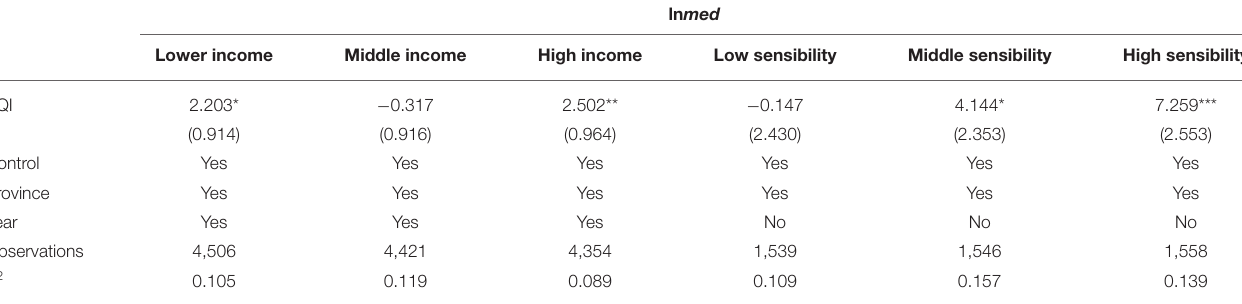
TABLE 4 | Impact of air pollution on household medical expenses: by income and with response sensibility